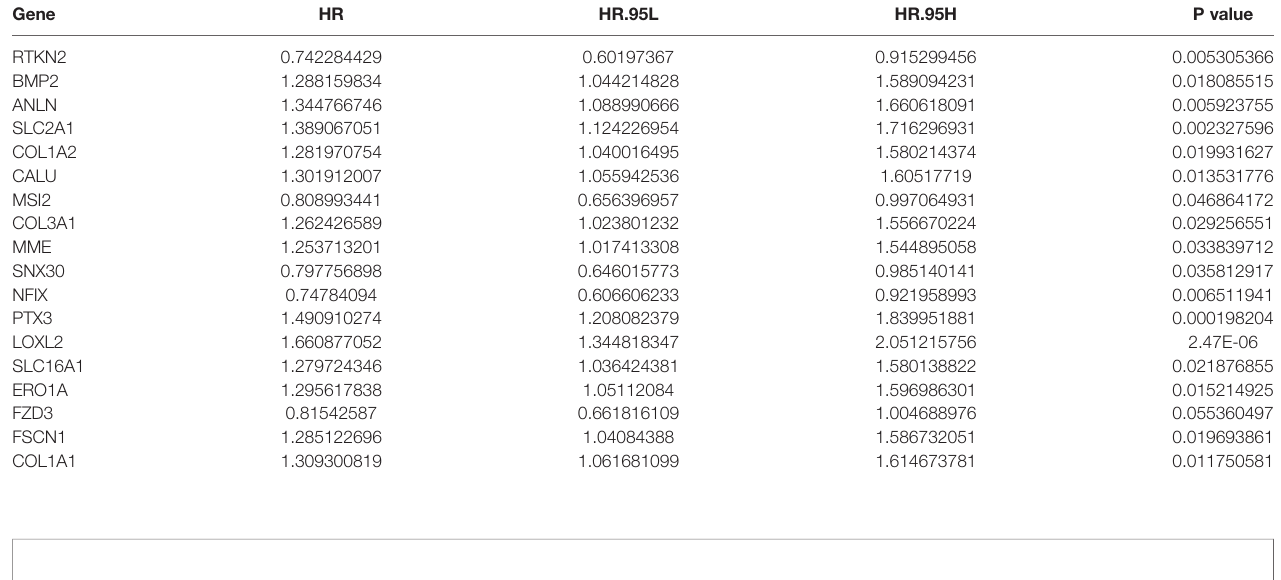
TABLE 3 | Univariate Cox regression analysis showed that the prognostic factors of NSCLC patients in ceRNA. network.